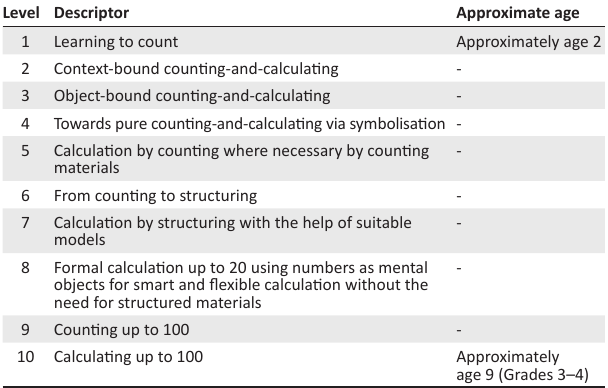
TABLE 1: Treffers and Buys’s trajectory from counting to